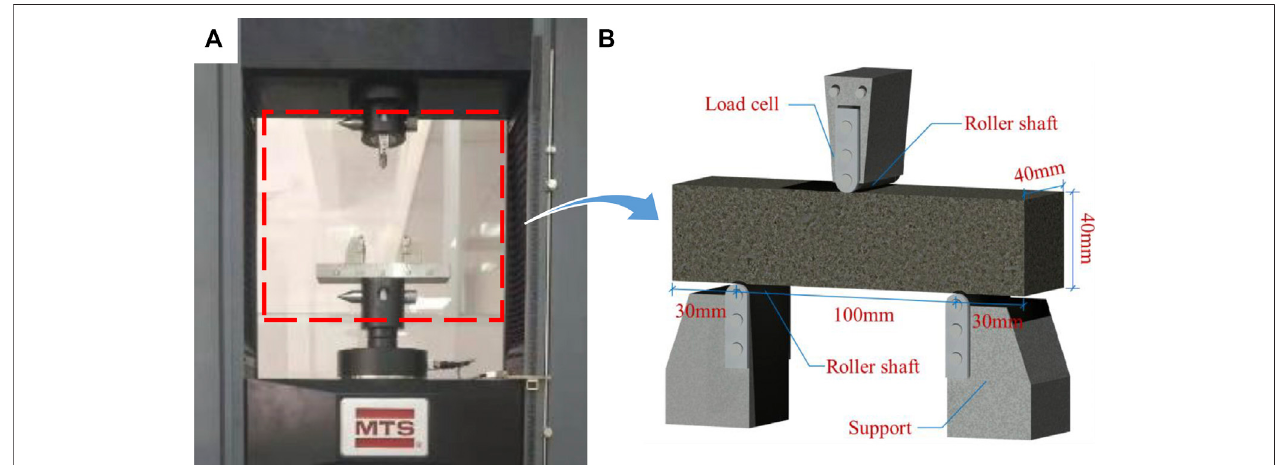
FIGURE 2 | Test setup (A) test machine; (B) test setup.